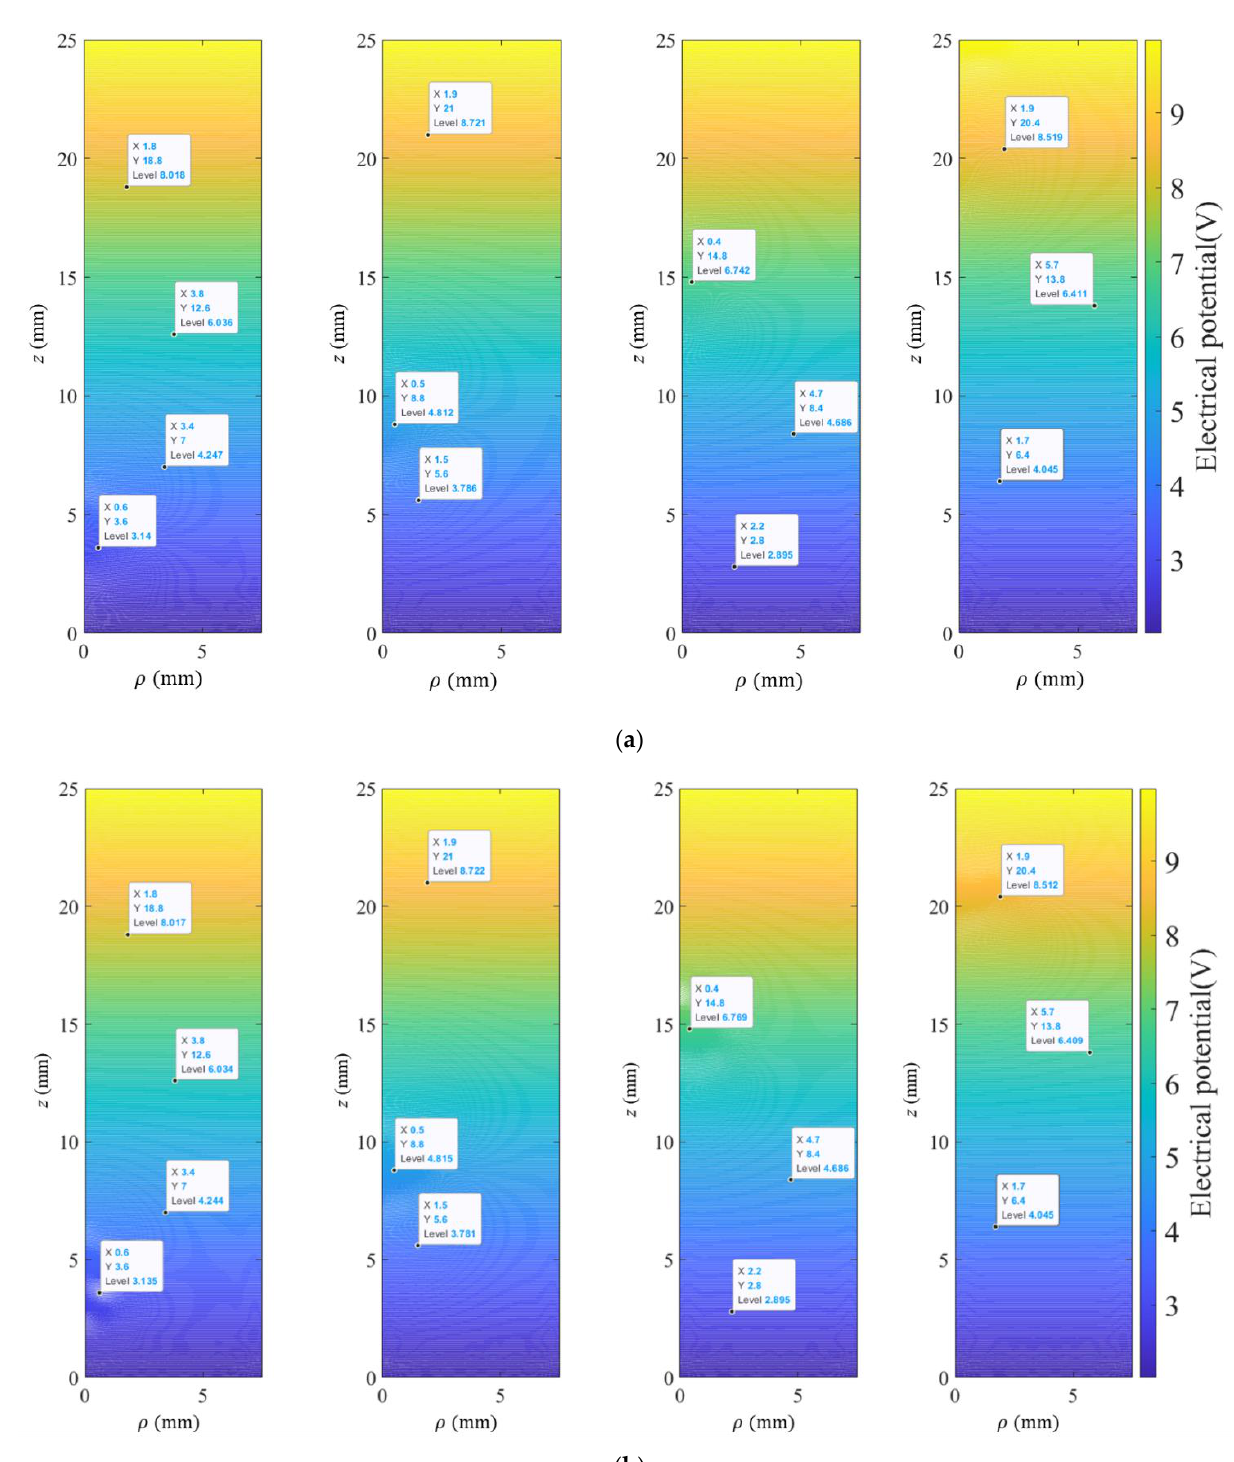
Figure 12. Electric potential distribution of a moving bubble in liquid nitrogen. ( a ) CFEM, ( b ) XFEM. The relative errors in each moment of electric potential based on CFEM and XFEM are shown in Table 3.